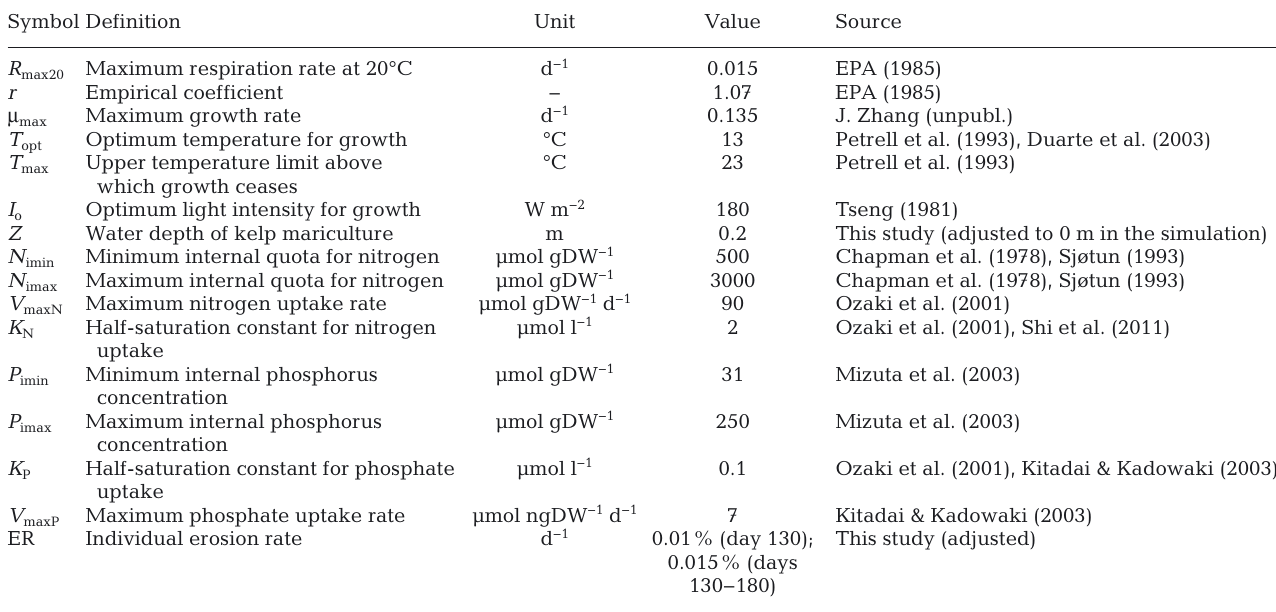
Table 1. Definitions and values of the parameters used in the kelp growth model. These are final values obtained by experimental procedure, field measurement, literature and/or calibration. DW: dry